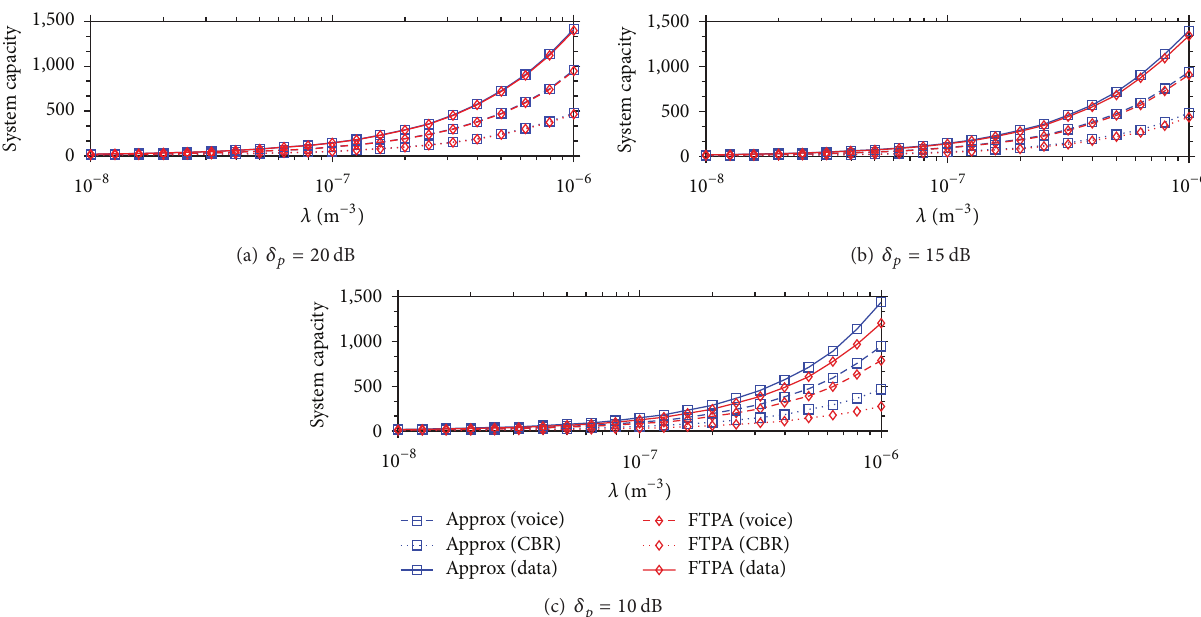
above. FTPA can decrease the MU outage probability by adjusting each FTP. However, decreasing each FTP results in decreasing the femtocell capacity. Figure 8(c) shows the consequence of decreasing FTP caused by FTPA that the aggregate system capacity is lower than that of